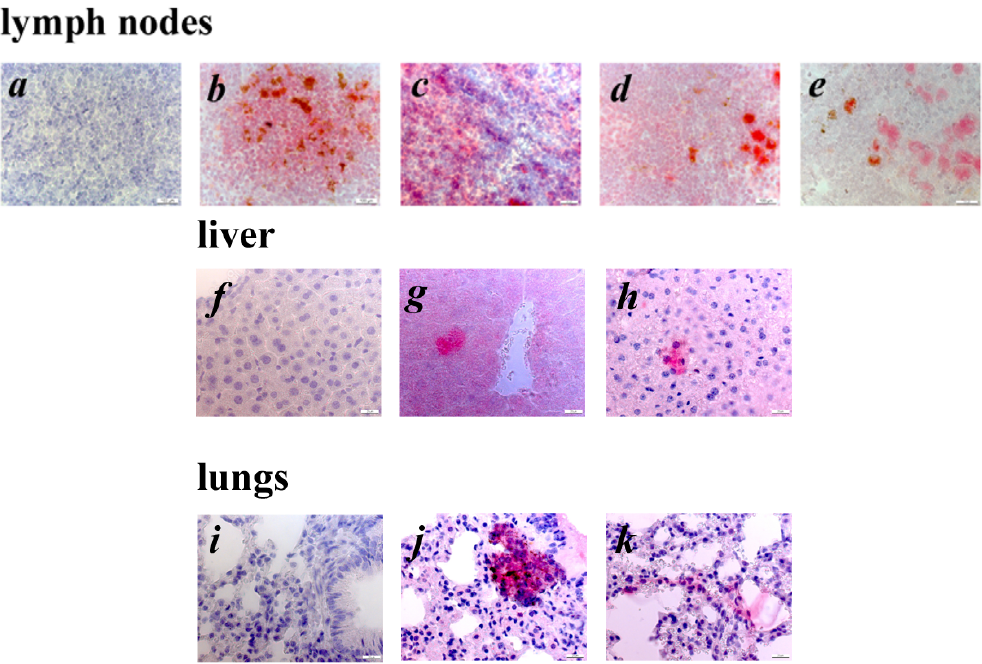
Figure 2. Detection of metastatic melanoma cells in distant organs of tumor bearing ret transgenic mice. Consecutive paraffin sections of LN ( a–e ), liver ( f–h ) and lungs ( i–k ) from tumor bearing ret transgenic mice (n = 10) were stained with rabbit anti-mouse polyclonal Abs against TRP-2 ( b , g , j ), TRP-1 ( c ), tyrosinase ( d ) and gp100 ( e , h , k ) and counterstained with hemalaun. Consecutive paraffin sections of LN ( a ), liver ( f ) and lungs ( i ) from non-transgenic littermates were used as control. Original magnification,